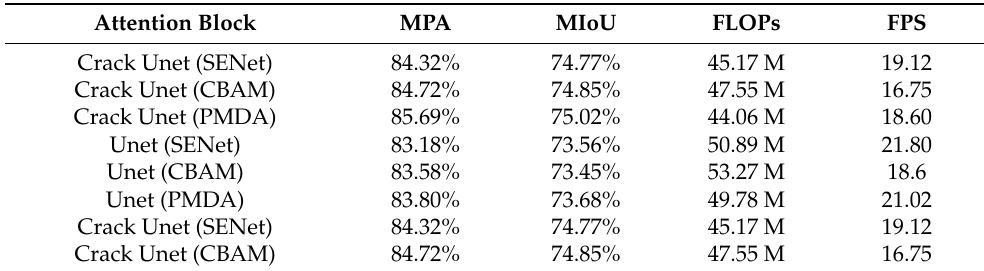
Table 6. Test results from different attention mechanisms on crack test